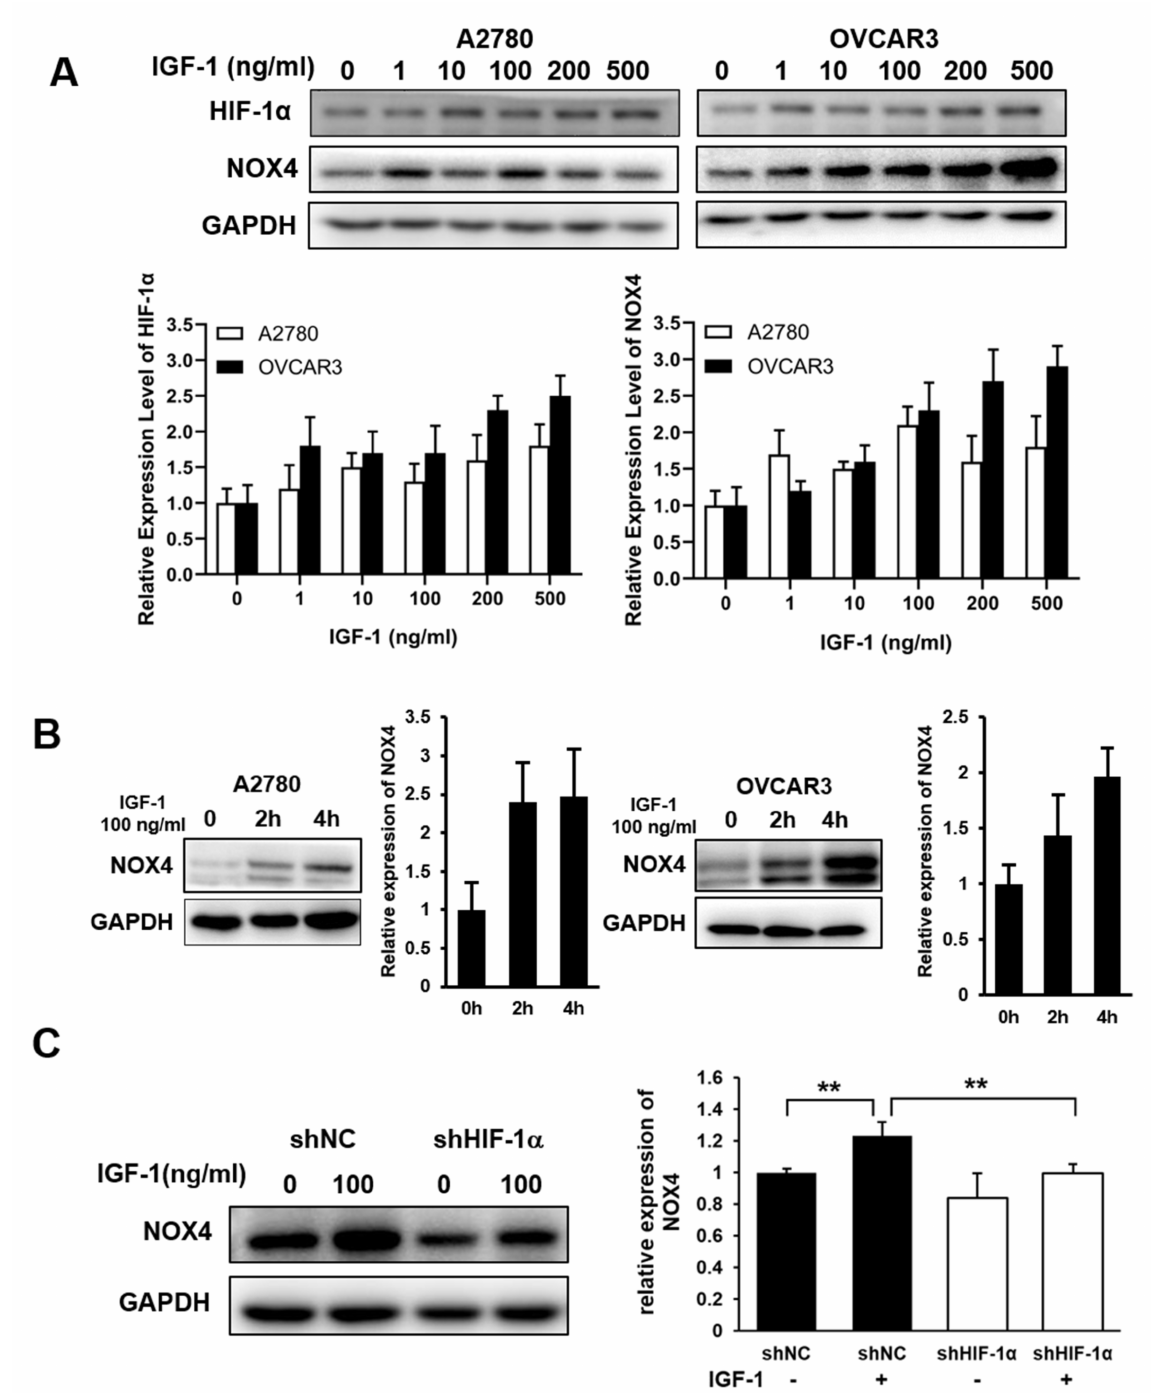
Figure 3. IGF-1 treatment increased the expression levels of HIF-1 α and NOX4 in A2780 and OVCAR3 cells. ( A ) Cells were serum starved for 16 h, and treated with the indicated concentrations of IGF-1 for 4 h. The expression levels of HIF-1 α and NOX4 were detected via Western blotting. ( B ) The serum-starved cells were treated with 100 ng/mL IGF-1 for 0 to 4 h, as indicated. The expression levels of NOX4 were analyzed by Western blotting. ( C ) The HIF-1 α knockdown cells were serum-starved and treated with 100 ng/mL IGF-1 for 4 h, the expression levels of NOX4 were analyzed by Western blotting. ** indicates significant difference at p <